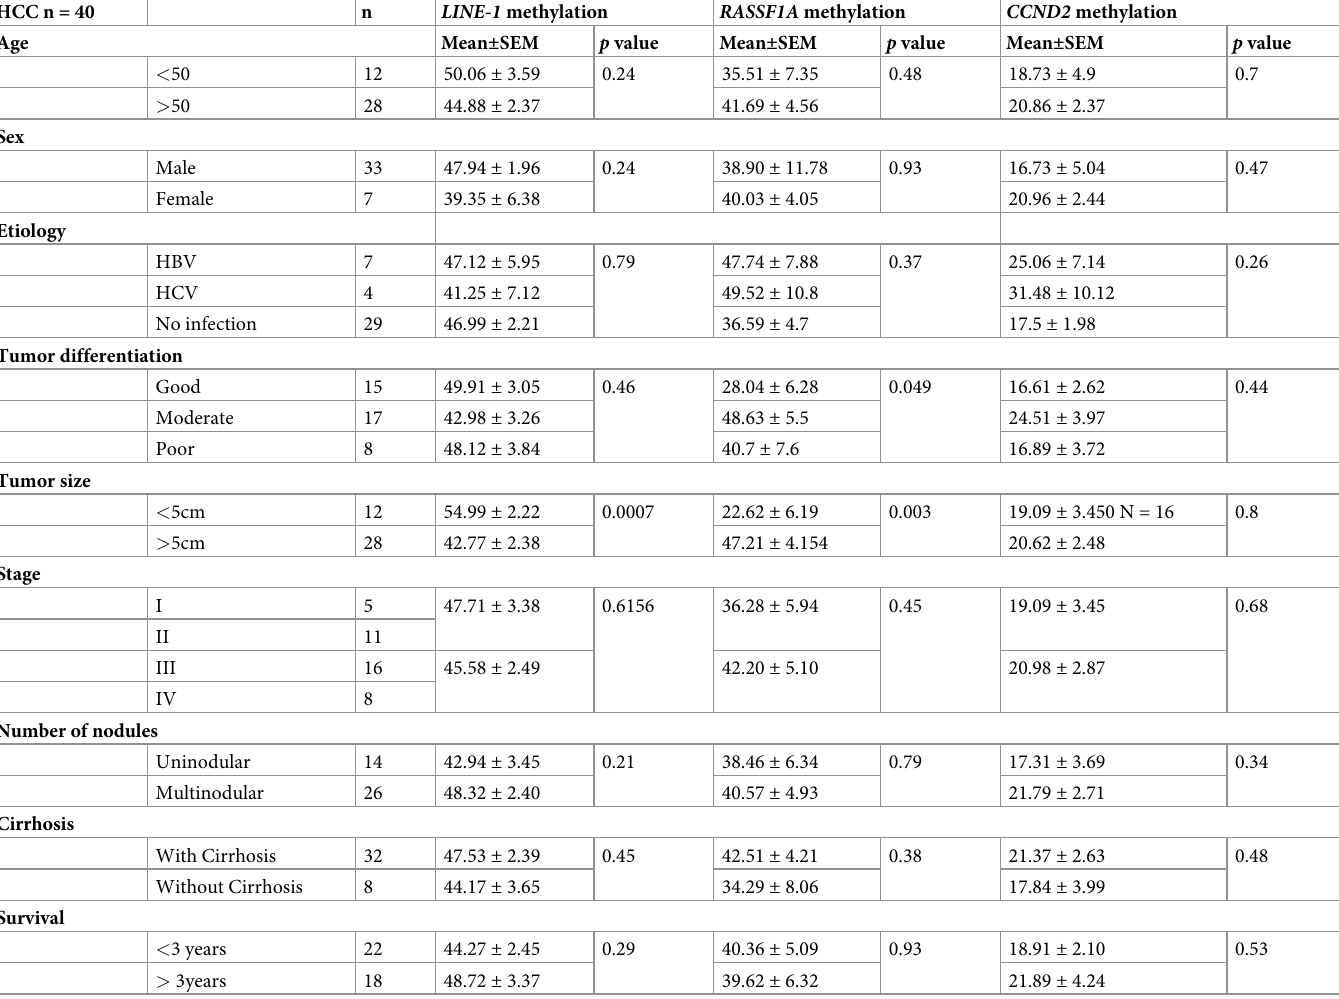
Table 1. Clinicopathological variables of HCC patients and comparison of LINE-1 , RASSF1A , and CCND2 DNA methylation